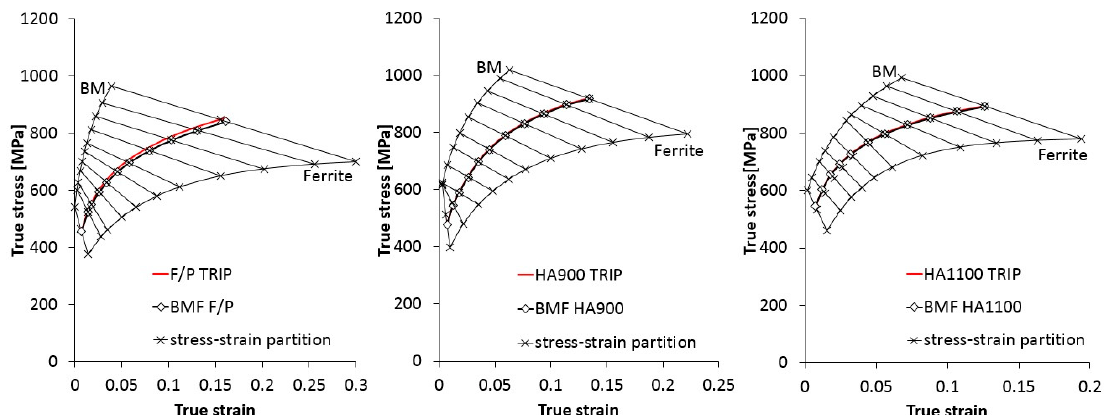
Figure 8. Stress-strain partition between Ferrite and BM for each steel.